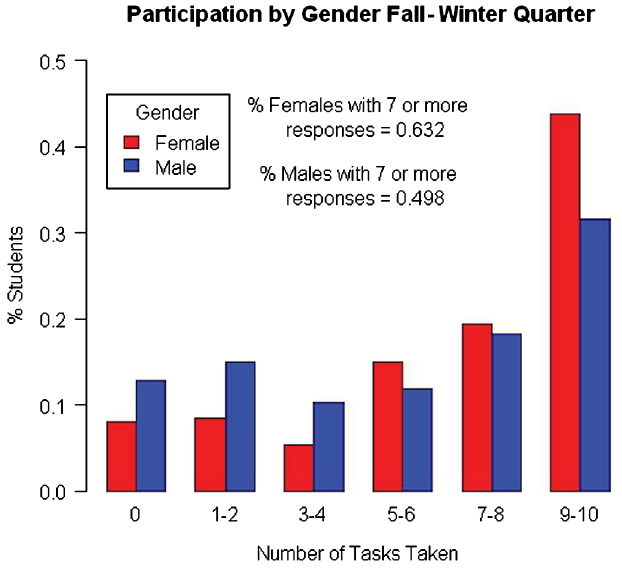
FIG. 2 (color online). Generally, women participate more often than men. The course is about 70% male.